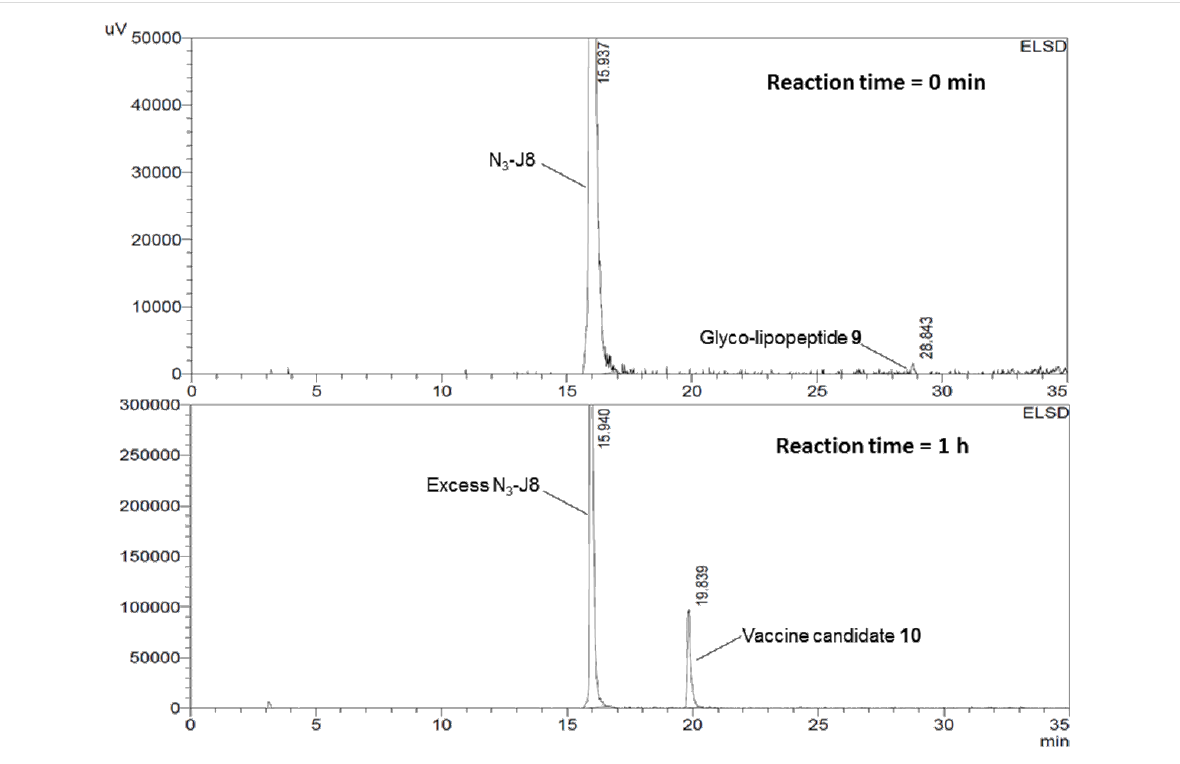
analytical RP-HPLC (C4 column, 0–100% solvent B (CH 3 CN/ 10% H 2 O/0.1% TFA)) and was complete in approximately 1 h (Figure 1). After purification by RP-HPLC vaccine candidate 10 was obtained in 32% yield and characterized by mass spec- trometry and RP-HPLC (Supporting Information File